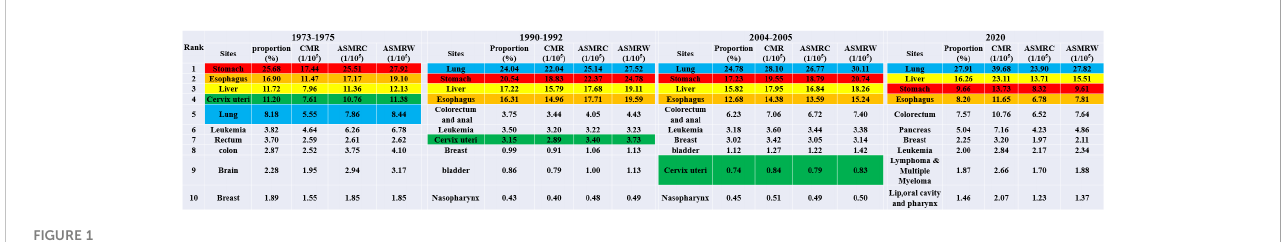
FIGURE 1 The top 10 cancer rank during the four periods in Inner